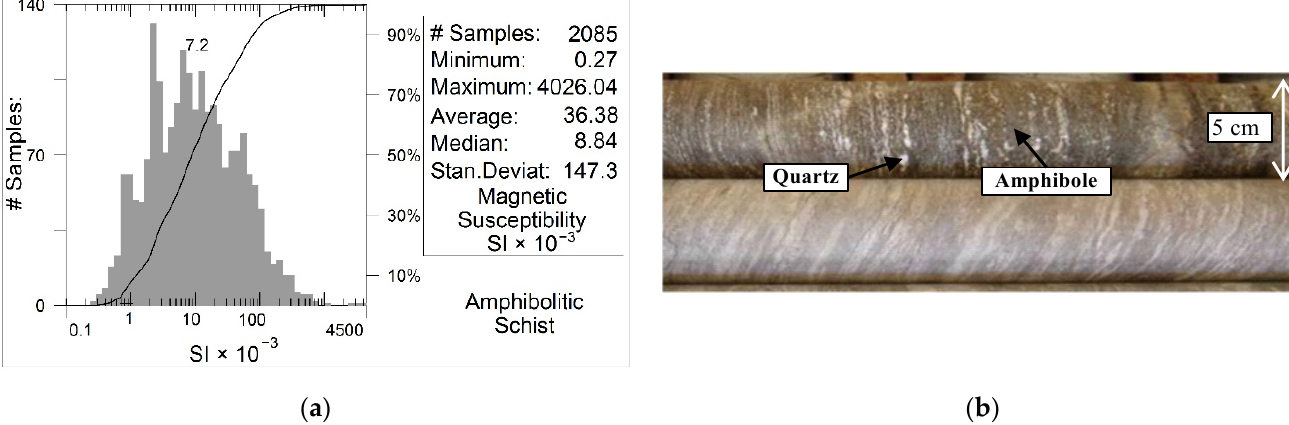
Figure A1. Amphibolitic schist. ( a ) Statistics and histograms of the magnetic susceptibility measurements. ( b ) Core samples picture.